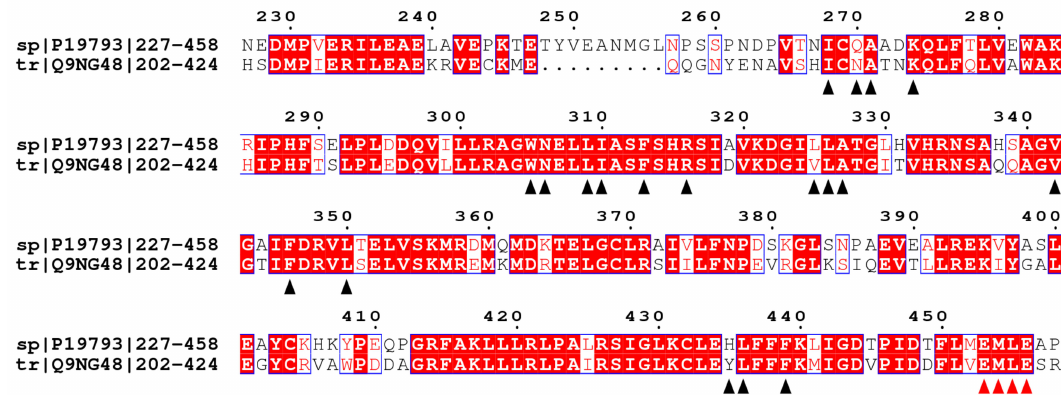
Figure 1. The proteins sequence alignment of H. sapiens RXR α (sp|P19793|) and A. mellifera USP (tr|Q9NG48|). The align- ment was done using ClustalX and ESPript. Black arrows indicate that the residues in H. sapiens bind the natural ligand. Red arrows indicate the EMLE sequence important for the stabilization of H12 in H. sapiens . The numbering at the top refers to the sequence of H. sapiens